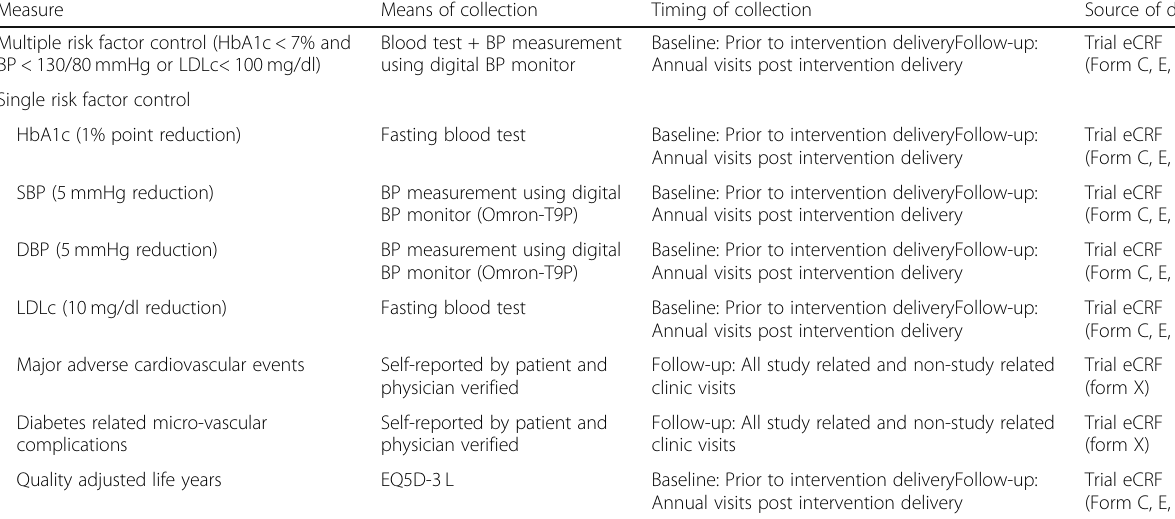
Table 1 Overview of the effectiveness measures Measure Means of